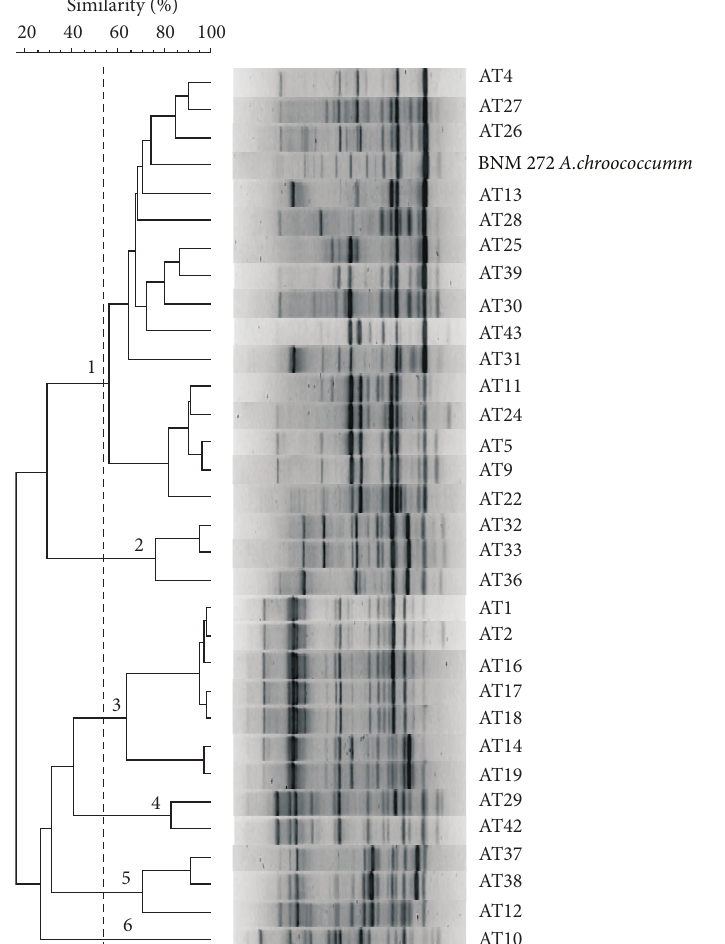
Figure 1: Genetic diversity of azotobacteria isolated from agricultural and non-agricultural soils from different regions of Argentina revealed by rep-PCR genomic fingerprinting analysis. The dendrogram was constructed by using the Pearson correlation coefficient ( 𝑟 ) and the UPGMA method using GelCompar II version 6.5 software. The groups indicated by 1 to 6 numbers were defined at the 55% similarity level (vertical dashed line). The cophenetic correlation value for this dendrogram was